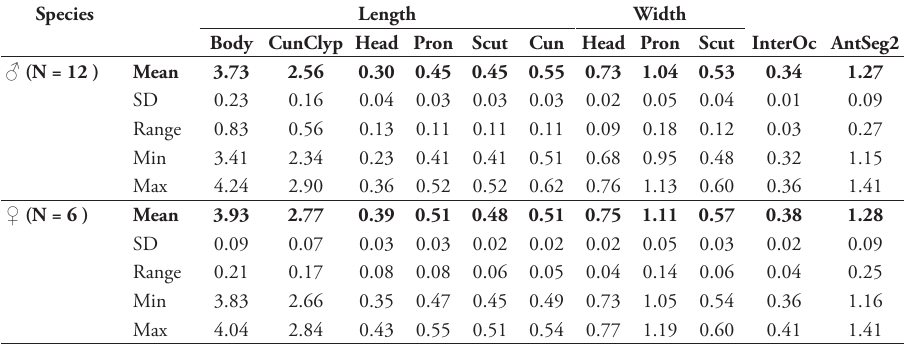
Table 1. Measurements of Henryognathus thomasi .